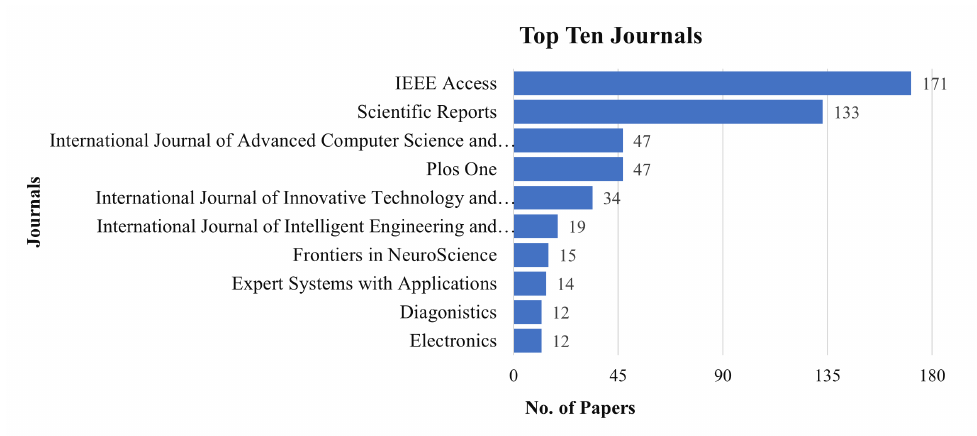
Figure 8. Publications by journals.